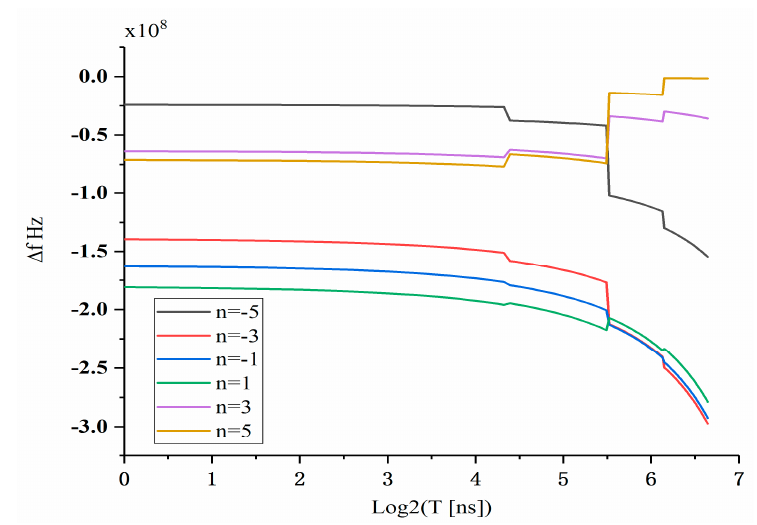
Figure 3. Frequency offset of array element.